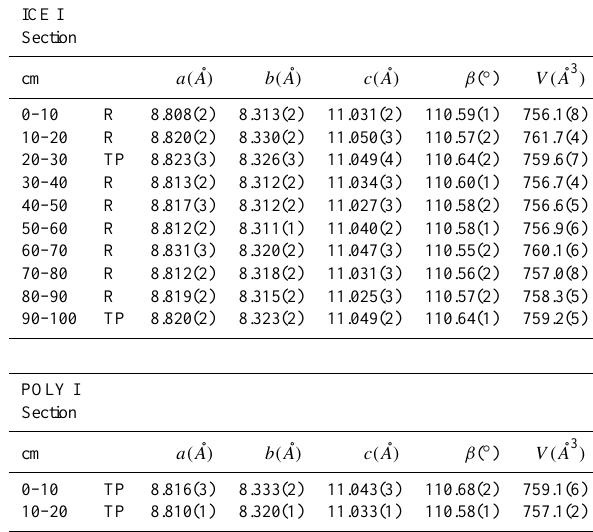
Table 1. X-ray diffraction data. Refined unit-cell parameters for ikaite crystals identified by x-ray diffraction analysis. ( ) = Standard deviation, R = rhombs, TP = thin plate.